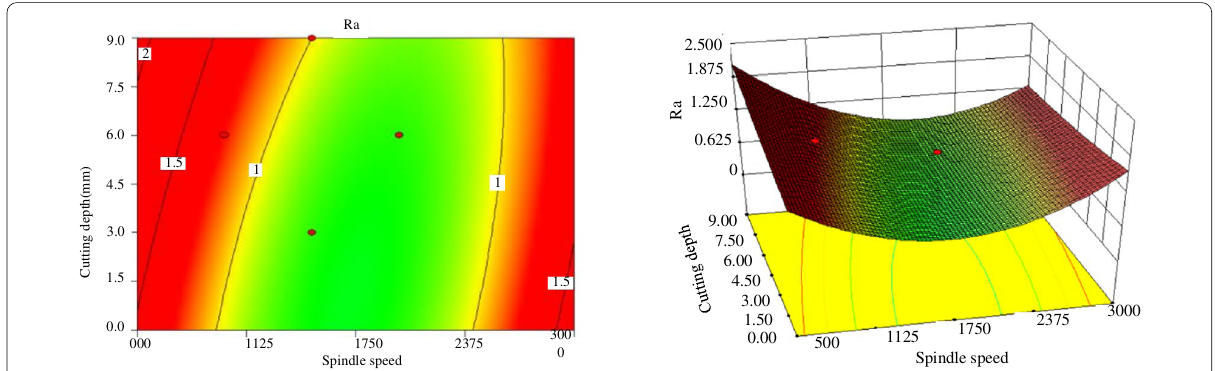
Figure 11 3D response surface figure of surface roughness regression equation [response surface and contour of ( A ) and ( C